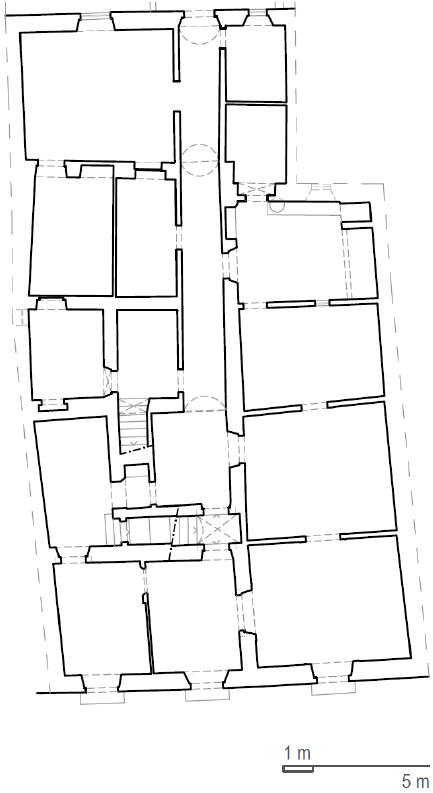
Figure 5. House in Rua de S. Bartolomeu,